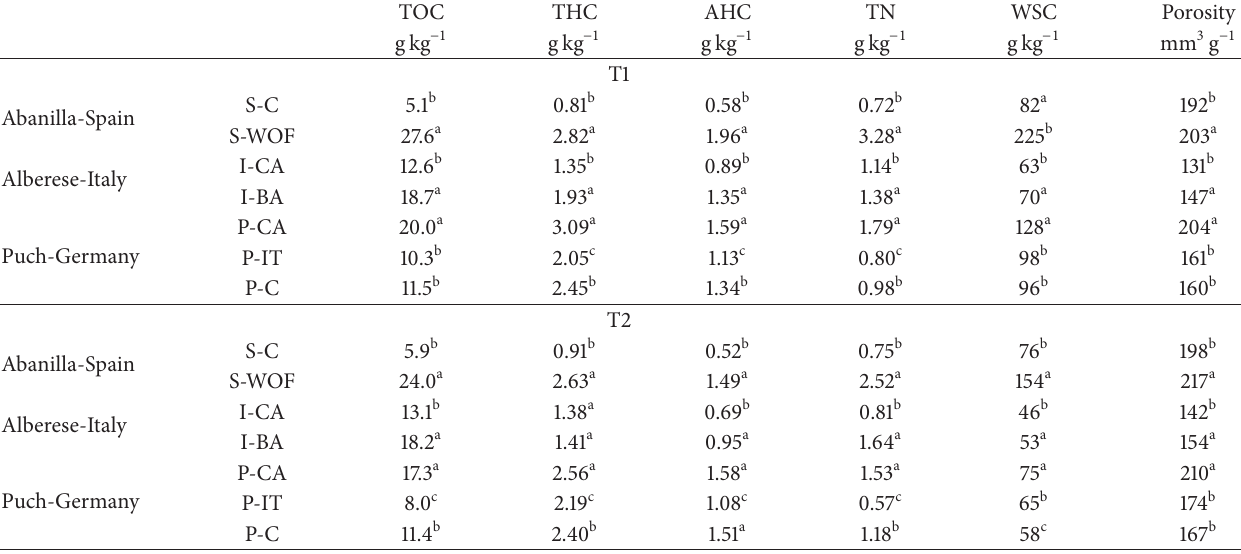
Table 1: Chemical and physical properties at T1 and T2 sampling times. For each site, different letters indicate statistically different values among the treatments ( 𝑃 < 0.05